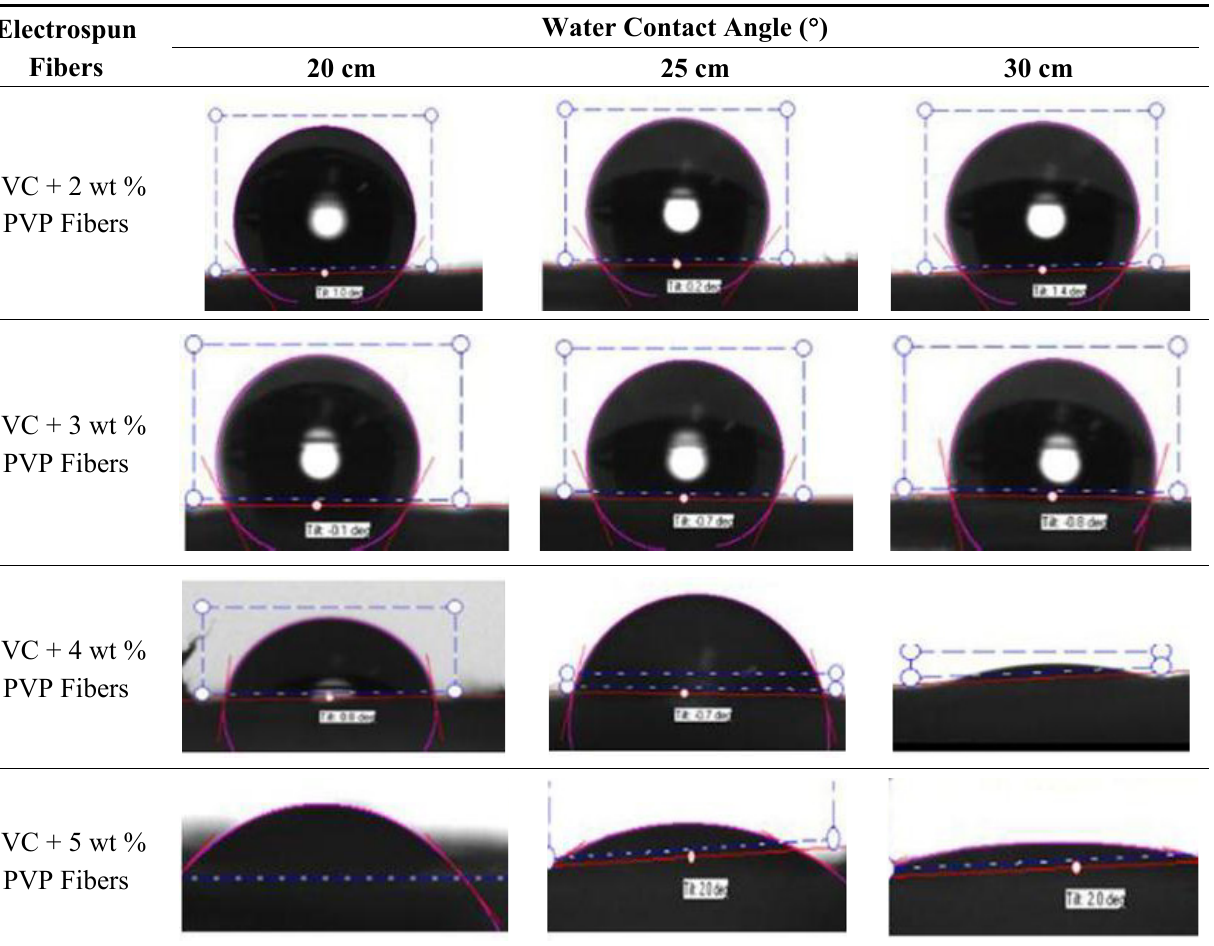
Table 2. Water contact angle values of PVC fibers incorporated with PVP at different separation